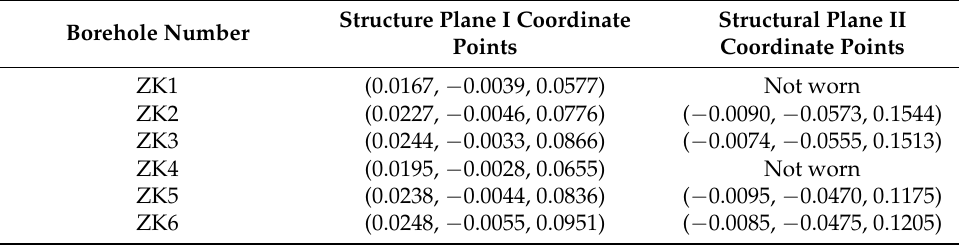
Figure 11. The fitted sine curve. Table 3. Structural plane coordinate points in sample 1.